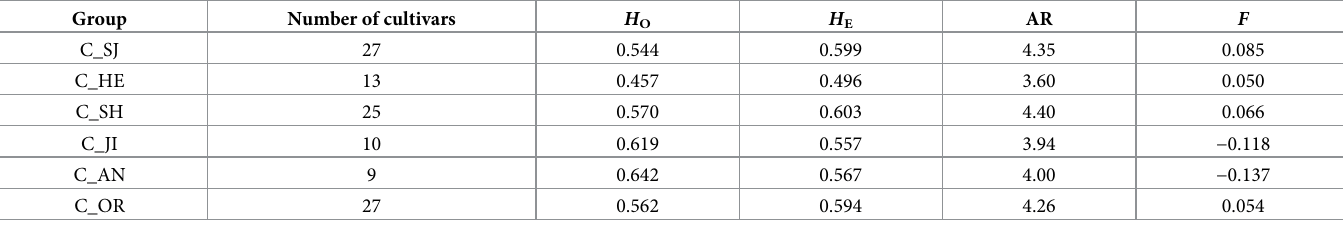
Table 5. Genetic characteristics of Chinese chestnut cultivar groups analyzed using 31